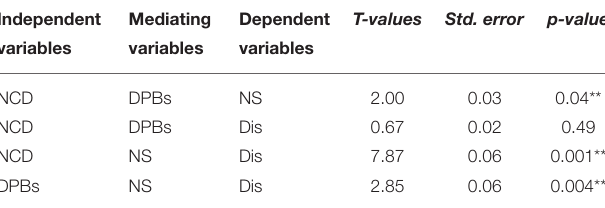
TABLE 5 | Sobel test results for indirect effects of neurocognitive deficits, dysfunctional performance beliefs, negative symptoms, and disability ( n =